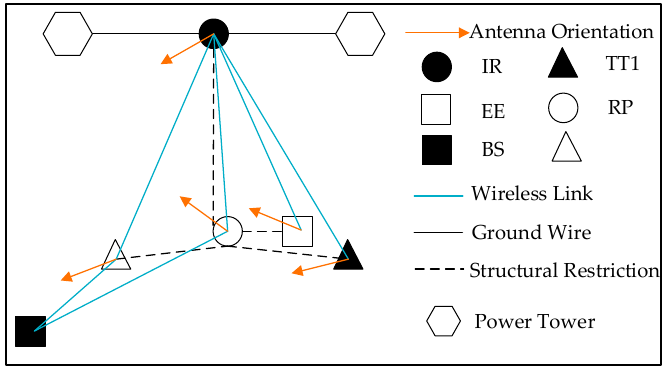
Figure 3. Distributed Branch-Trimming Robot Network (DBTRN).